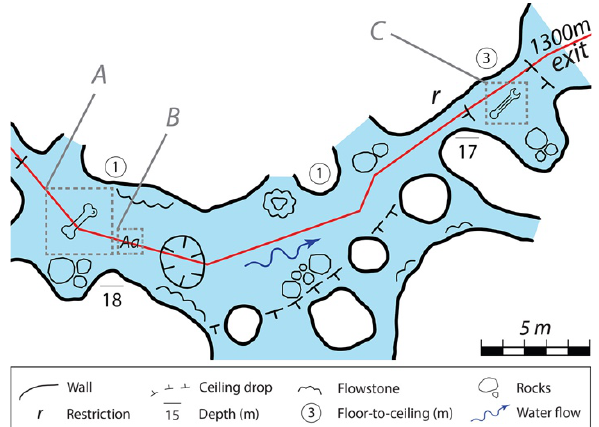
Figure 10 . Cave map illustrating the different photogrammetric study areas: (A) the acquisition zone (downstream, 1 m floor-to- ceiling height, 18 m depth) ; (B) the legend zone (next to the photogrammetry zone, downstream) ; (C) the preparation zone (further downstream, 3 m floor-to-ceiling height, before the restriction “r”) (CINDAQ)